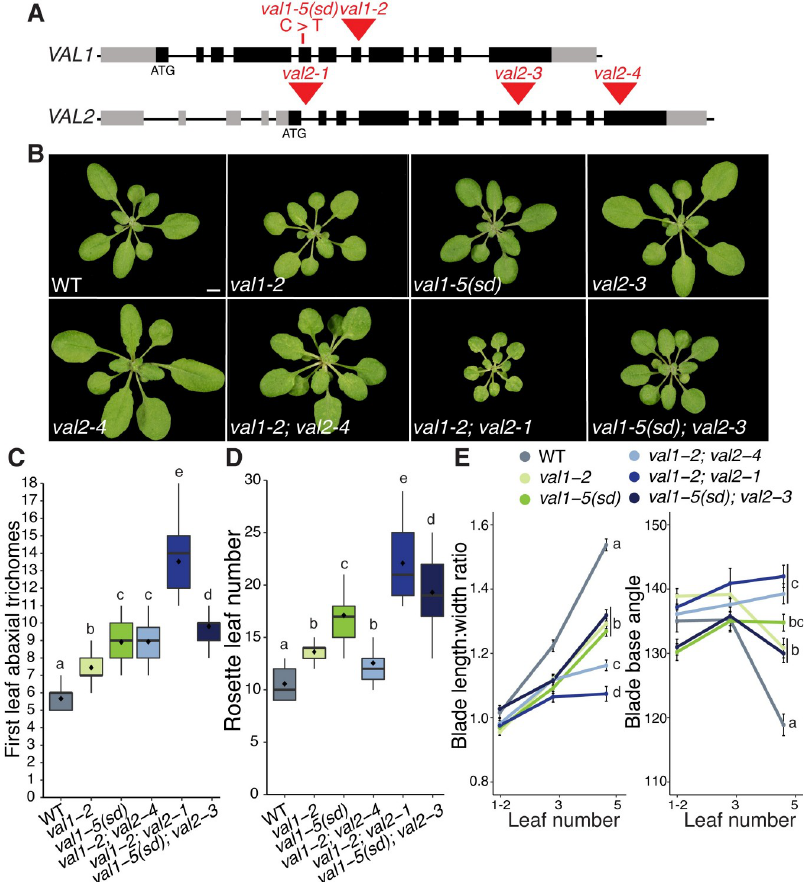
Fig 1. VAL genes redundantly regulate vegetative phase change. (A). Schematic of val1 and val2 alleles used in this study–grey boxes represent UTRs, black boxes represent exons, red triangles represent T-DNA insertions, red line represents EMS-induced base substitution. (B) Phenotypes at 21 DAG in LD conditions, scale bar = 5mm. (C-E) Quantitative analysis of vegetative development. Statistically distinct genotypes were identified by one-way ANOVA with post hoc Tukey multiple comparison test (letters indicate statistically distinct groups P < 0.05; for (E) comparisons were made at leaf 5), all plants grown in LD. (C,D) Boxes display the interquartile range (IQR) (boxes), median (lines) and values beyond 1.5 � IQR (whiskers); mean values are marked by ♦ . (E) Colored lines represent the mean and black bars the SEM. Sample sizes (C, D) 21–46, (E) 13–46. phase change (Figs 1B and S1F). However, loss of VAL2 activity enhanced the phenotypes of val1-2 and val1-5(sd) . val1-2; val2-4 and val1-5(sd); val2-3 both exhibited delayed abaxial tri- chome production relative to val1-2 and val1-5(sd) , respectively (Fig 1C). val1-5(sd) ; val2-3 flowered significantly later than val1-5(sd) (Fig 1D) and val1-2; val2-4 produced leaves that were significantly more juvenile in shape (i.e. rounder) than val1-2 (Fig 1E). Neither double mutant combination was as phenotypically severe as val1-2; val2-1 (Fig 1C, 1D and 1E). The weaker phenotype of val1-5(sd); val2-3 compared to val1-2; val2-3 [16,35], and stronger effects of val2 in the val1-2 than val1-5(sd) background (Fig 1E), suggests that the semi-dominant phenotype of val1-5(sd) is mediated by interaction with VAL2 . Importantly, the rate of germi- nation was higher in val1-2; val2-4 and val1-5(sd); val2-3 relative to existing val1; val2 double mutants. val1-2; val2-4 and val1-5(sd); val2-3 thus provide a balance between phenotypic strength and experimental viability and are useful tools for investigating the role of VAL genes in developmental timing.